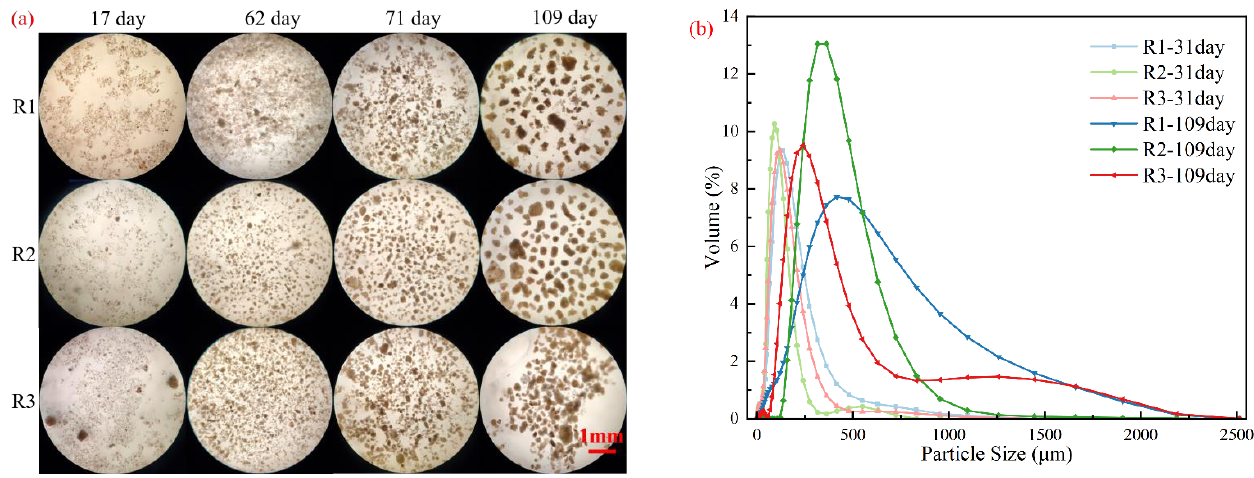
Figure 4. The morphology of the aerobic granular sludge particles under optical microscopy ( a ), the particle size distribution of the aerobic granular sludge ( b